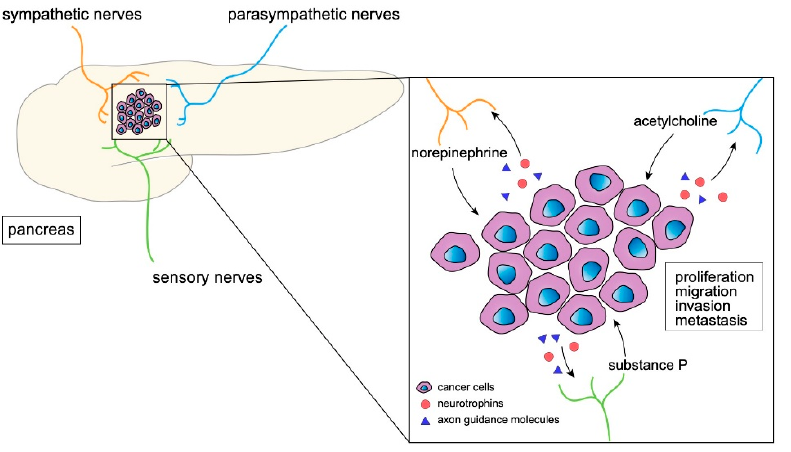
Figure 1. The interaction of neural cells and tumor cells. A schematic figure depicting the interaction of cancer cells and neural cells via various molecules.